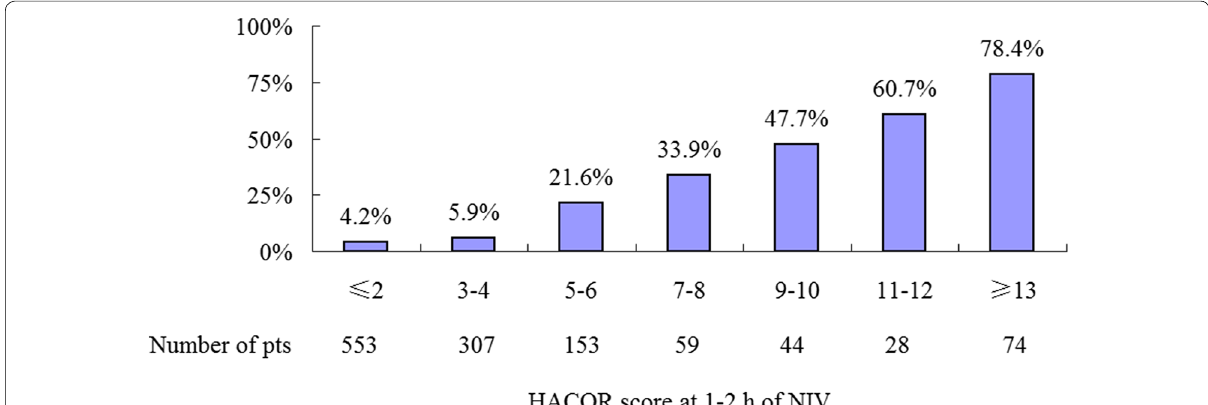
Fig. 2 NIV failure rates in patients with different HACOR scores. Pts patients, NIV noninvasive ventilation, HACOR heart rate, acidosis, consciousness, oxygenation, and respiratory rate